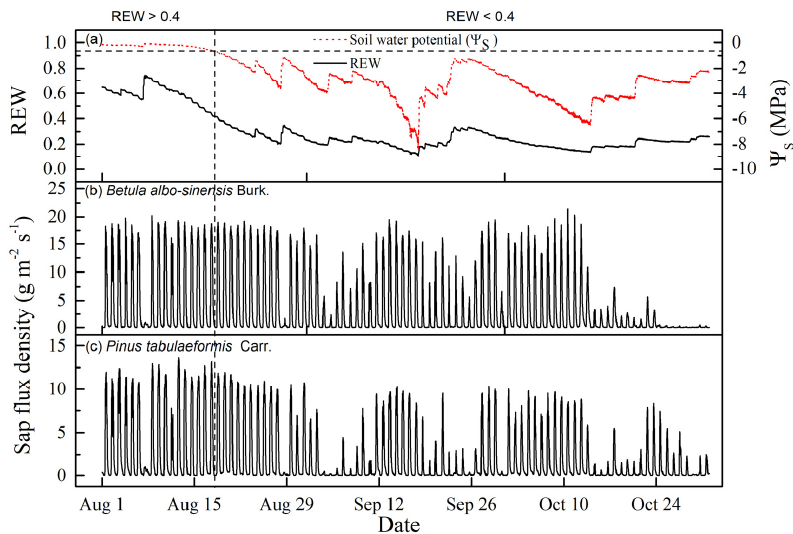
Figure 5. Seasonal variations in ( a ) the relative extractable water (REW), ( b ), ( c ) sap flux density for both species over the study period. The vertical black dashed line represents the division of soil ‐